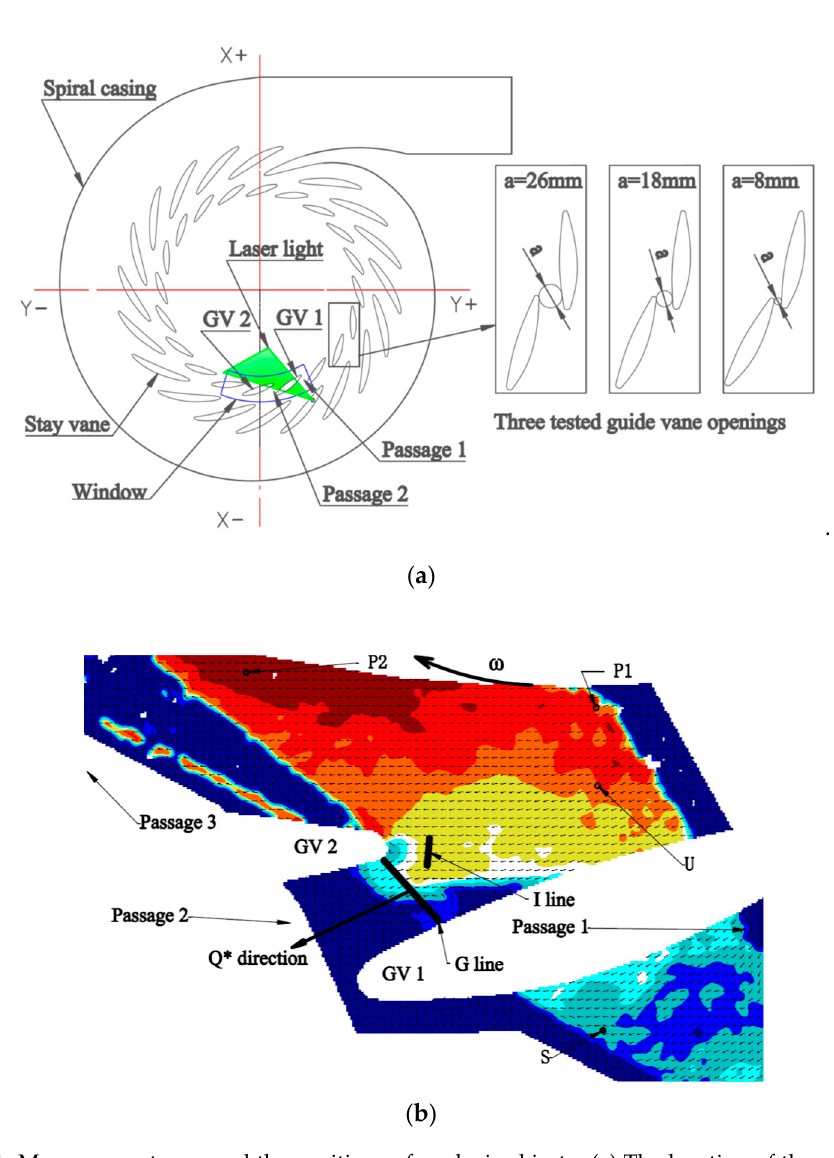
Figure 4. Measurement area and the positions of analysis objects. ( a ) The location of the measured window from the bottom view; ( b ) The positions of analysis objects for flow velocity.